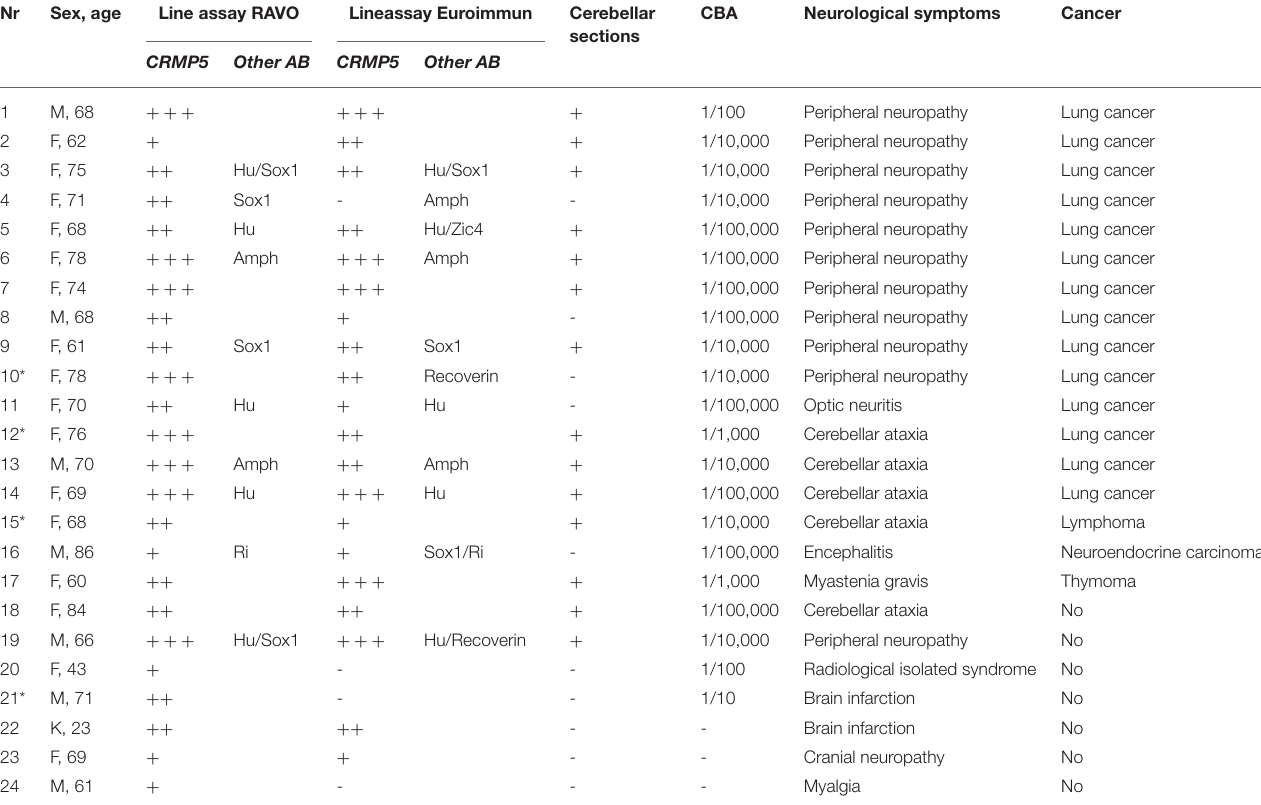
TABLE 1 | Diagnostic and clinical findings in 24 patients with CRMP5 antibodies.